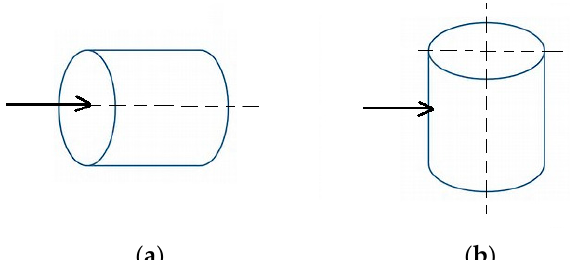
Figure 1. Diagram illustrating laser beam penetration through wood samples: ( a ) along the grain, ( b ) across the grain.